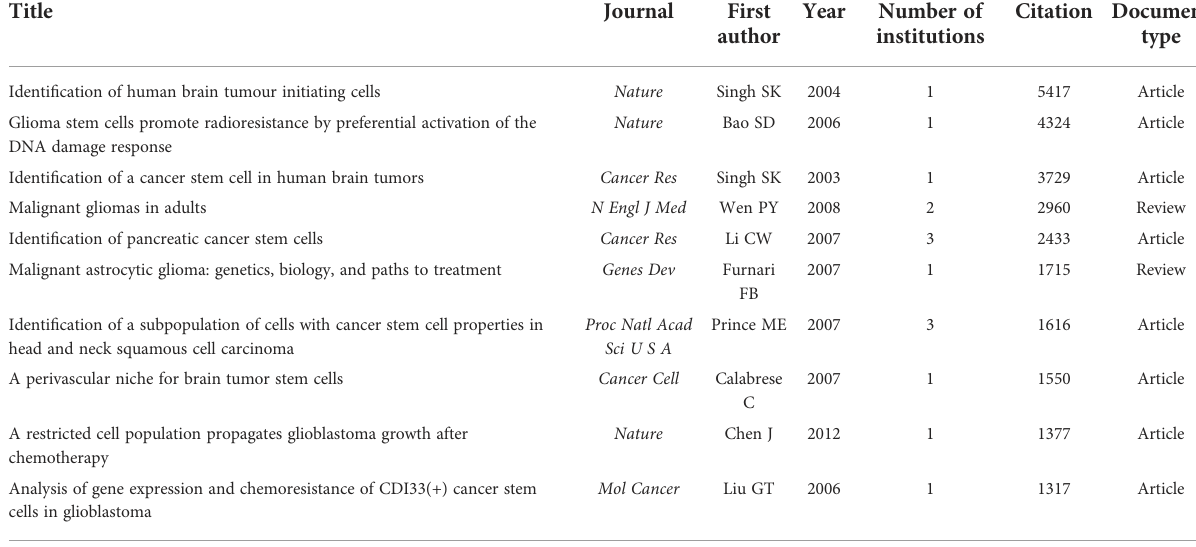
TABLE 6 The 10 most cited papers of research on glioma stem cells from 2003 to